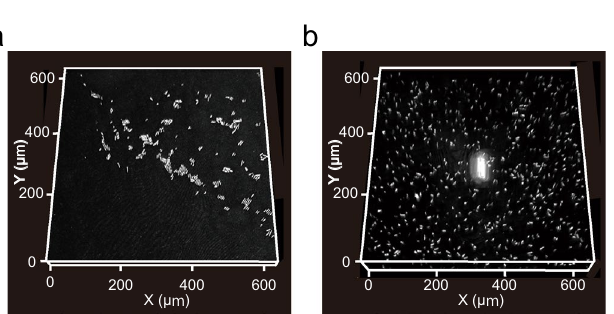
Figure 3. Z-stack images and 3D projection of S. pombe JY1 around the ( a , b ) glass surface or ( c , d ) MY-133-EA surface. Numbers under z-stack images show the z-positions from the interface (unit: μm) and bars are 20 μm throughout. The images were obtained by optical system equipped with a 561-nm continuous wave laser, a 100 × oil-immersion lens (NA = 1.45, RI = 1.515) and a pinhole of 1.2 AU. The z-resolution is 0.5 μm. Note that deterioration of NA by IMM was not taken into account to calculate resolution. The 3D projection depicts the range of 20.5 μm along vertical z-axis.